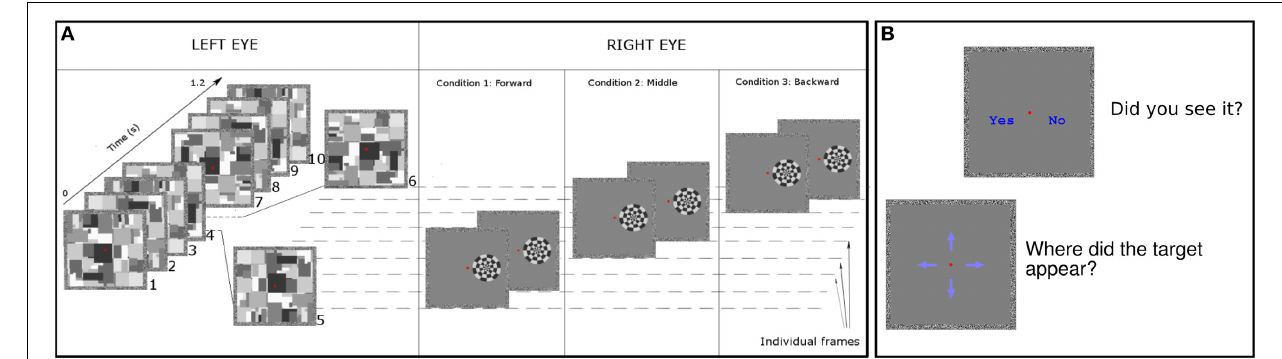
FIGURE 1 | Experimental design. (A) We presented Mondrian patterns to left eye of subjects (leftmost panel in the figure) at frequency of 8.5Hz in Experiment 1. For Experiment 2 we used a range of frequencies. Targets were always displayed to the right eye of subjects. As an example, we show three trials occurring between the 5th and 6th Mondrian presentation. Forward condition : we displayed targets on the screen in the following two frames ( ∼ 24ms) after the Mondrian. Middle condition : we presented targets